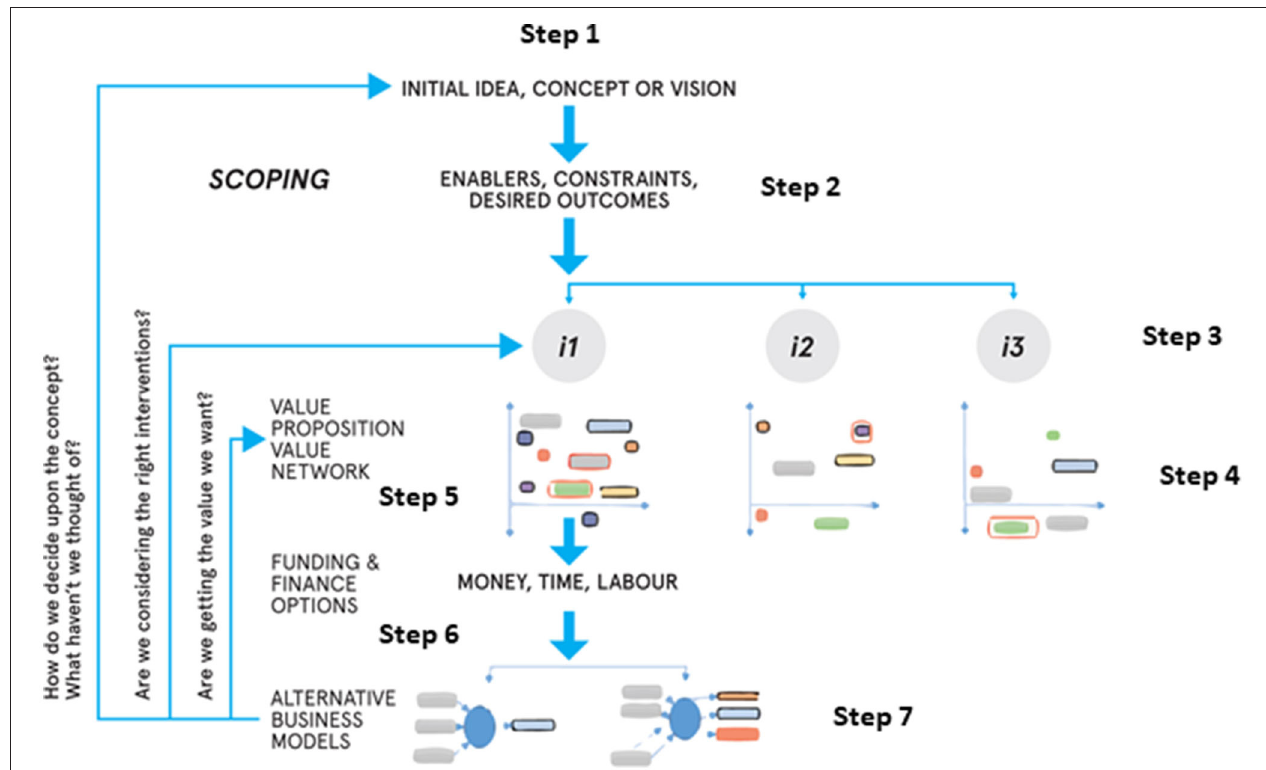
FIGURE 1 | Framework for infrastructure business